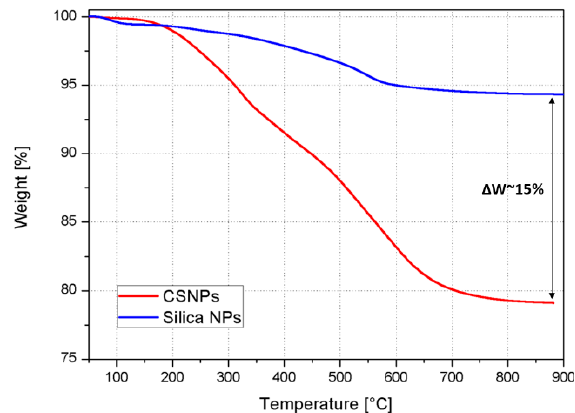
Figure 6. TGA thermograms (in nitrogen) of (blue curve) functionalized NPs and (red curve) CSNPs.